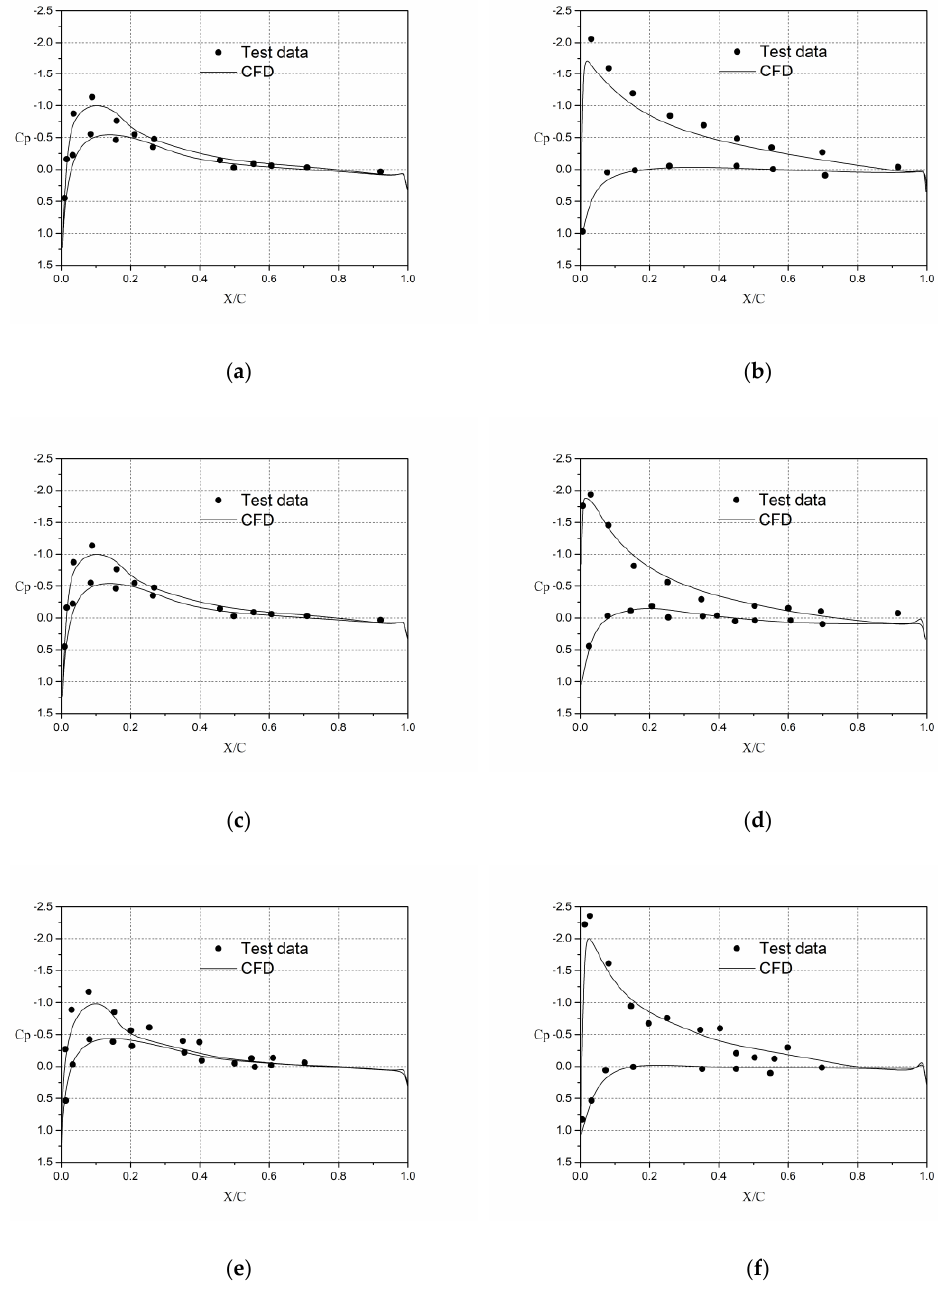
Figure 8. PressurecoefficientofAH-1Grotorvarieswithazimuthandbladesection. ( a ) ψ = 30 ◦ , r ⁄ R = 0.60. Figure 8. Pressure coefficient of AH-1G rotor varies with azimuth and blade section. ( a ) ψ = ( b ) ψ = 180 ◦ , r ⁄ R = 0.60. ( c ) ψ = 90 ◦ , r ⁄ R = 0.91. ( d ) ψ = 270 ◦ , r ⁄ R = 0.91. ( e ) ψ = 90 ◦ , r ⁄ R = 0.97. 30°,𝑟 𝑅⁄ = 0.60 . ( b ) ψ = 180°, 𝑟 𝑅⁄ = 0.60 . ( c ) ψ = 90°, 𝑟 𝑅⁄ = 0.91 . ( d ) ψ = 270°,𝑟 𝑅⁄ = 0.91 . ( e ) ( f ) ψ = 270 ◦ , r ⁄ R = ψ = 90°, 𝑟 𝑅⁄ = 0.97 . ( f ) ψ = 270°, 𝑟 𝑅⁄ = 0.97 .